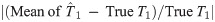
Comparing the T1 estimates’ accuracy for four different approaches: NLSE with the new TSI sequence (blue), NLSE with the original TSI sequence (cyan), DESPOT1 (green), and NLSE with the SPGR sequence (black).The accuracy is measured in terms of the relative bias %, calculated as |(Mean of T^1 − True T1)/True T1|. This experiment uses a nominal T1 value of 1500 ms. Simulated SNR levels are calibrated equivalently as 5 ≤ SNR ≤ 60 for the TSI sequences and 40 ≤ SNR ≤ 480 for the SPGR sequence. The new TSI sequence achieves the lowest overall relative bias and therefore highest accuracy among the four approaches.